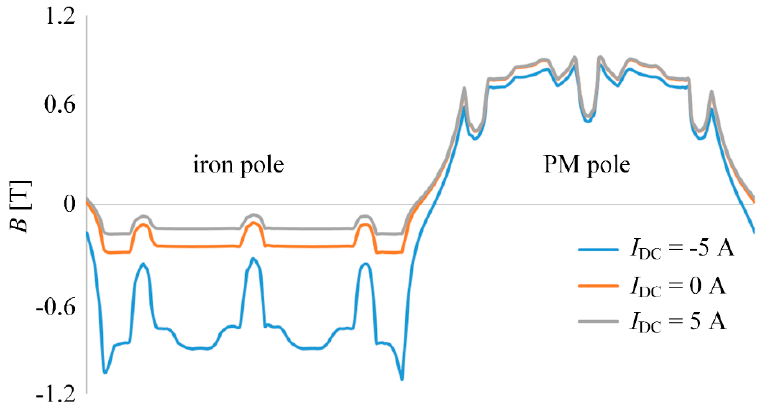
Figure 13. The distribution of magnetic induction in air gap for different currents in the DC coil [55].